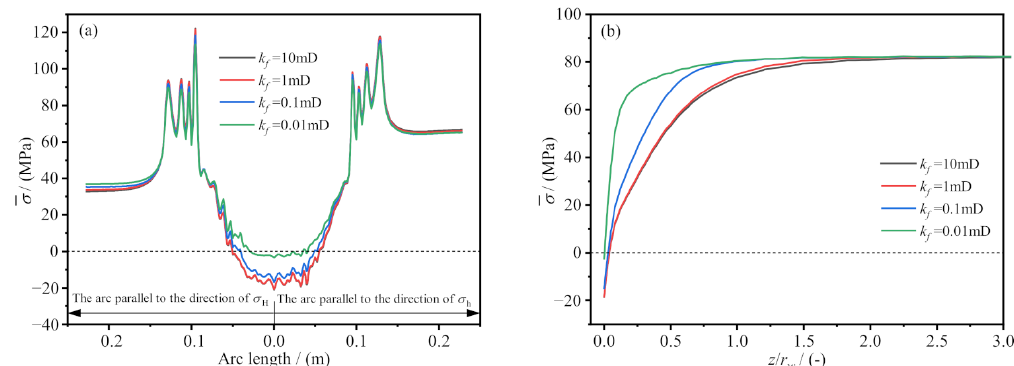
Figure 10. Average effective stress of the bottomhole rocks under different formation permeability conditions. ( a ) The arc parallel to the direction of σ H and σ h ; ( b ) The line along the axis of the borehole.